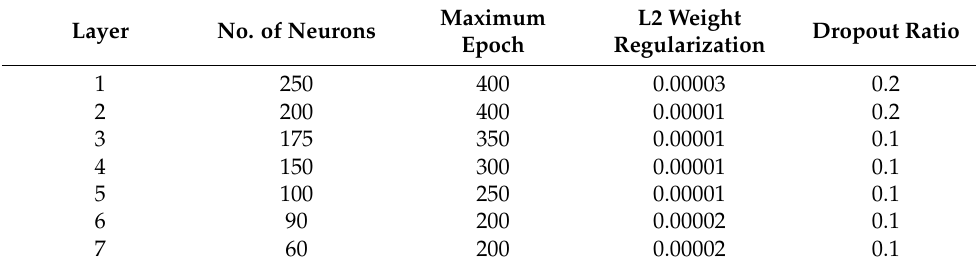
Table 2. The optimal fine-tuned configuration selected for Windfarm 2.